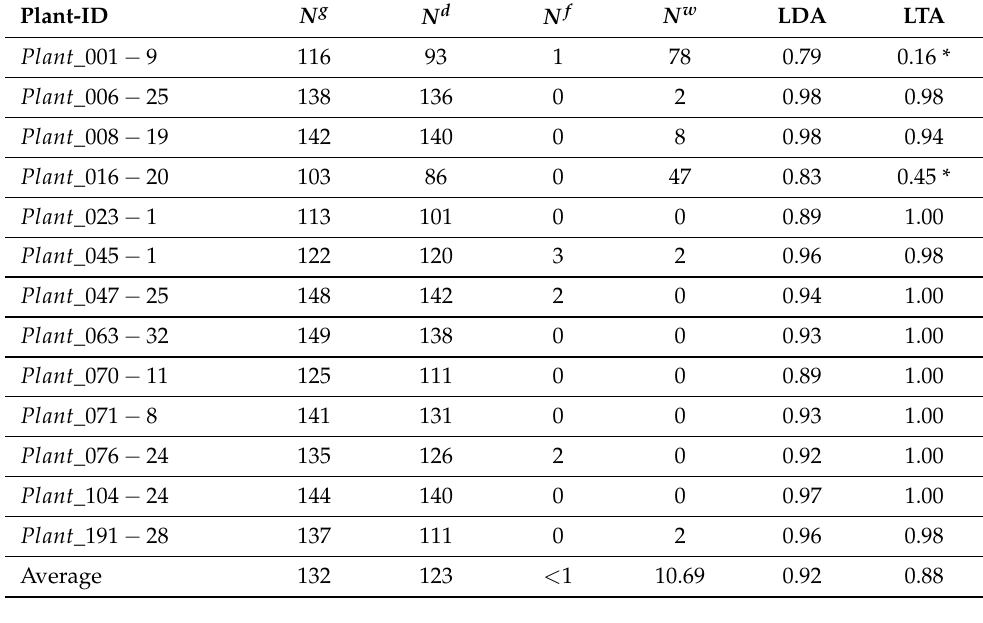
Table 2. Performance summary of the UNL-CPPD-I dataset. Keys—‘ N g ’: number of leaves in